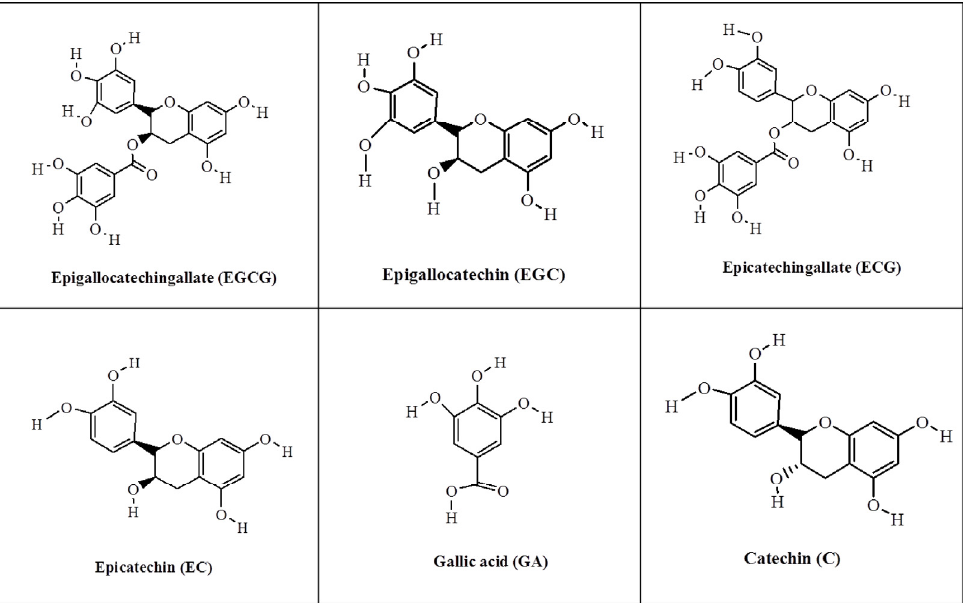
Figure 1. The chemical structures of the main polyphenols in green tea.